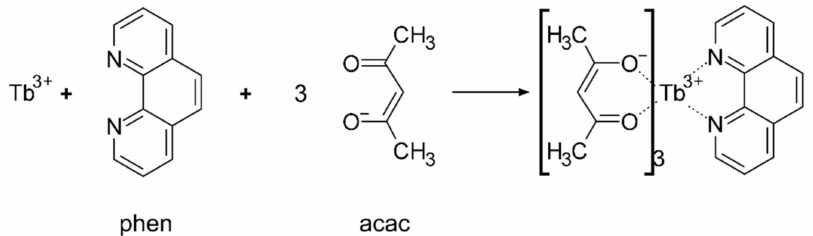
Figure 2. Synthetic procedure for Tb(acac) 3 phen.